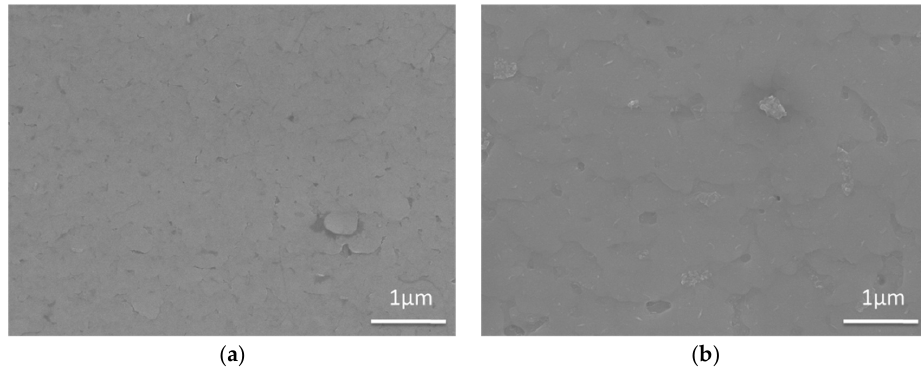
Figure 10. SEM images of GdYBCO films prepared based on the multi-aperture shower. ( a ) SEM image of the edge position; ( b ) SEM image of the middle position.